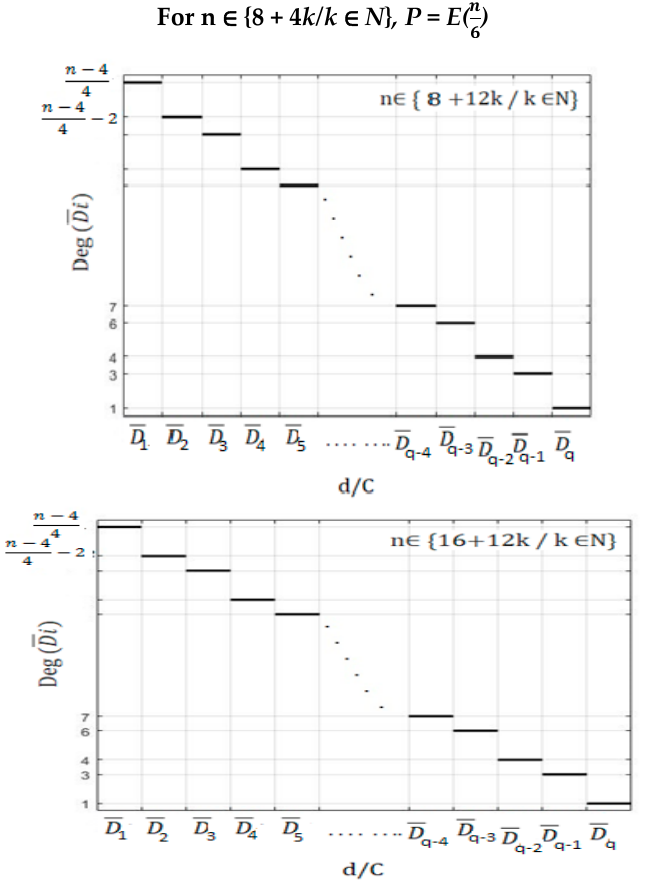
Figure 6. A generalization making possible to find the variation of domain degeneracy for any even number of vaccination centres.